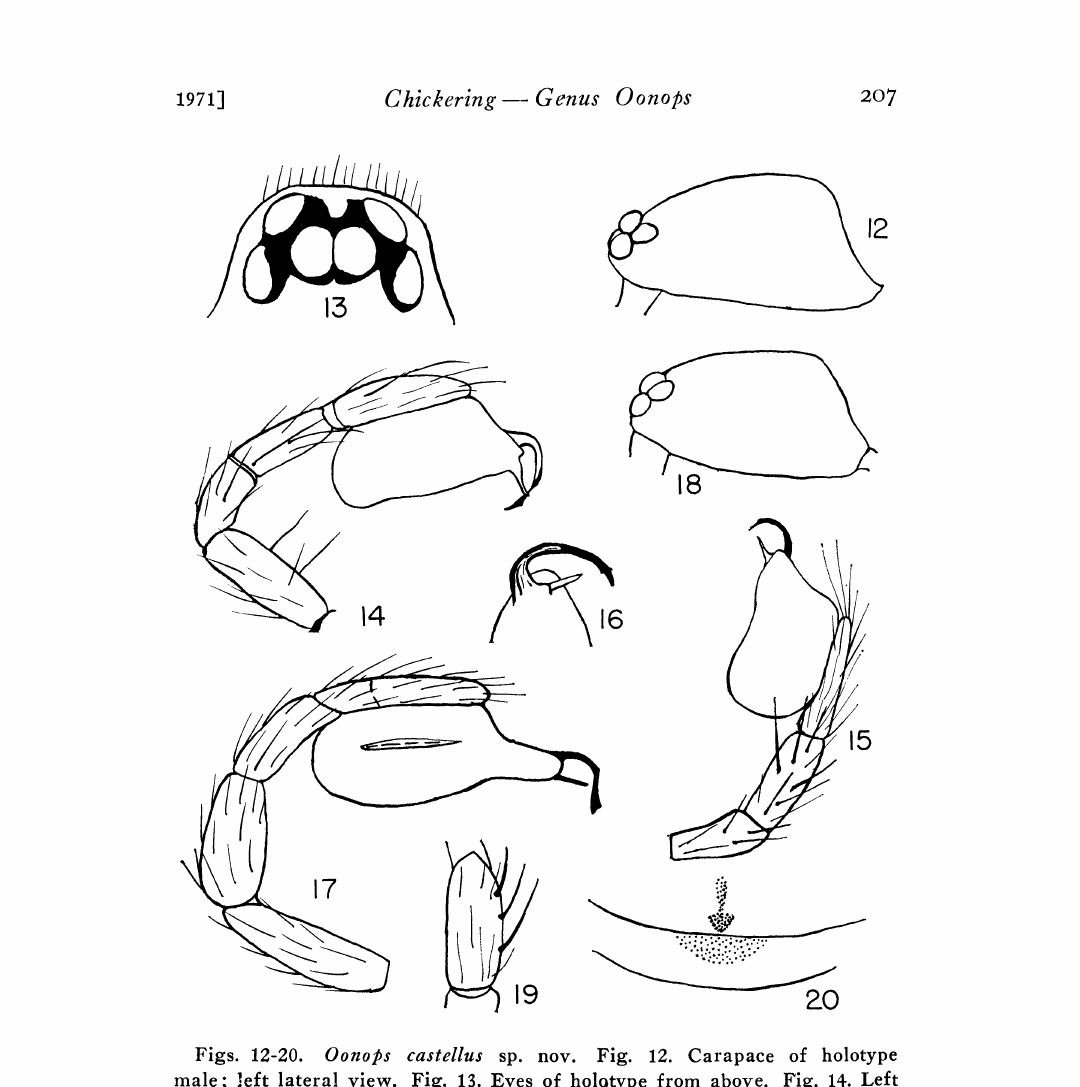
Figs. 12-20. Oonops castellus sp. nov. Fig. 12. Carapace of holotype male; !eft lateral view. Fig. 13. Eyes of holotype from above. Fig. 14. Left palp of holotype; prolater,al view. Fig. 15. Right palp of male paratype; prolateral view. Fig. 16. Tip of right palpal tarsus of male paratype; nearly ventral view; more enlarged. Fig. 17. Left palp of male from St. Croix, V. I.; prolateral view. Fig. 18. Carapace of second female paratype; left lateral view. Fig. 19. Left palpal patella of described female paratype; dorsal view. Fig. 20. Epigynal area of described female paratype from